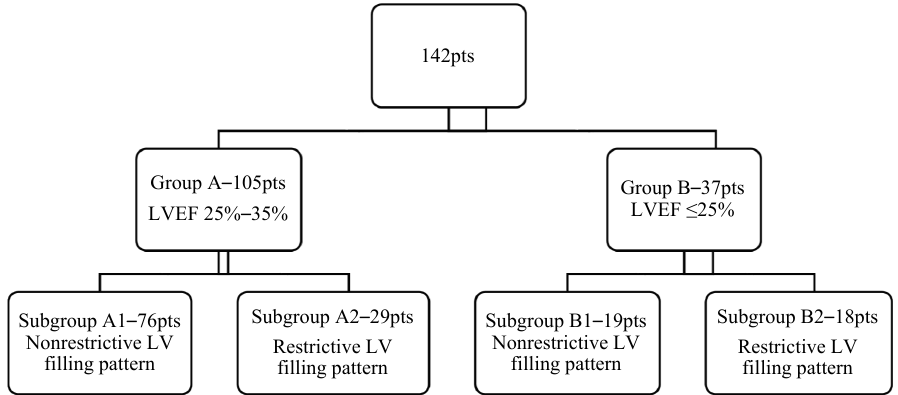
Figure 1. Study group structure depending on LV systolic and diastolic performance. The demographic characteristics (mean age, gender), secondary mitral regurgitation degree and the mean pulmonary artery pressure were similar in the two study groups.